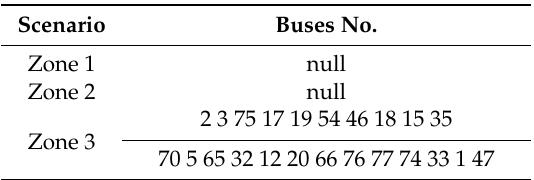
Table 4. The number of buses with voltage exceeding boundary.